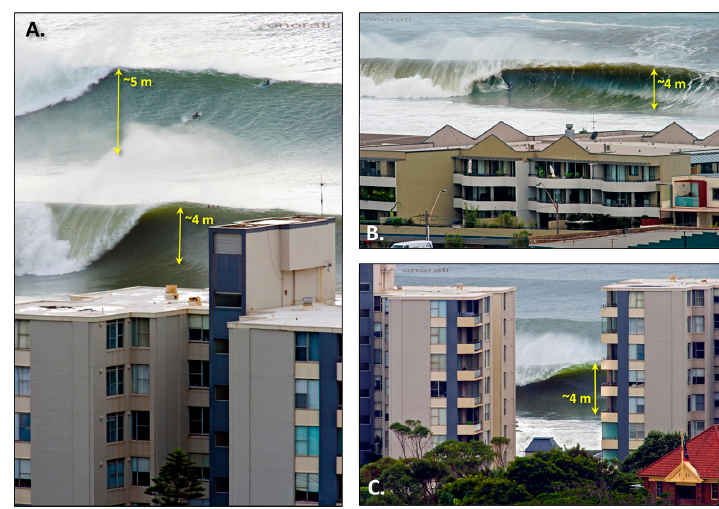
Figure 7. Nearshore wave conditions at South Narrabeen on Monday 6 June 2016. Authors’ and photographer’s visual estimates of breaking wave heights from these images are between 4 and 5 m (~13 to 16 ft.). Reproduced with permission from Mark Onorati [38]. The images in ( A ) and ( C ) are of the beach section behind Narrabeen Fire Station (red brick building in foreground in ( C )) approximately half the way along the Narrabeen ‐ Collaroy embayment; the image in ( B ) is 100 m north of ( A ) and ( C ) adjacent to Robertson Street.